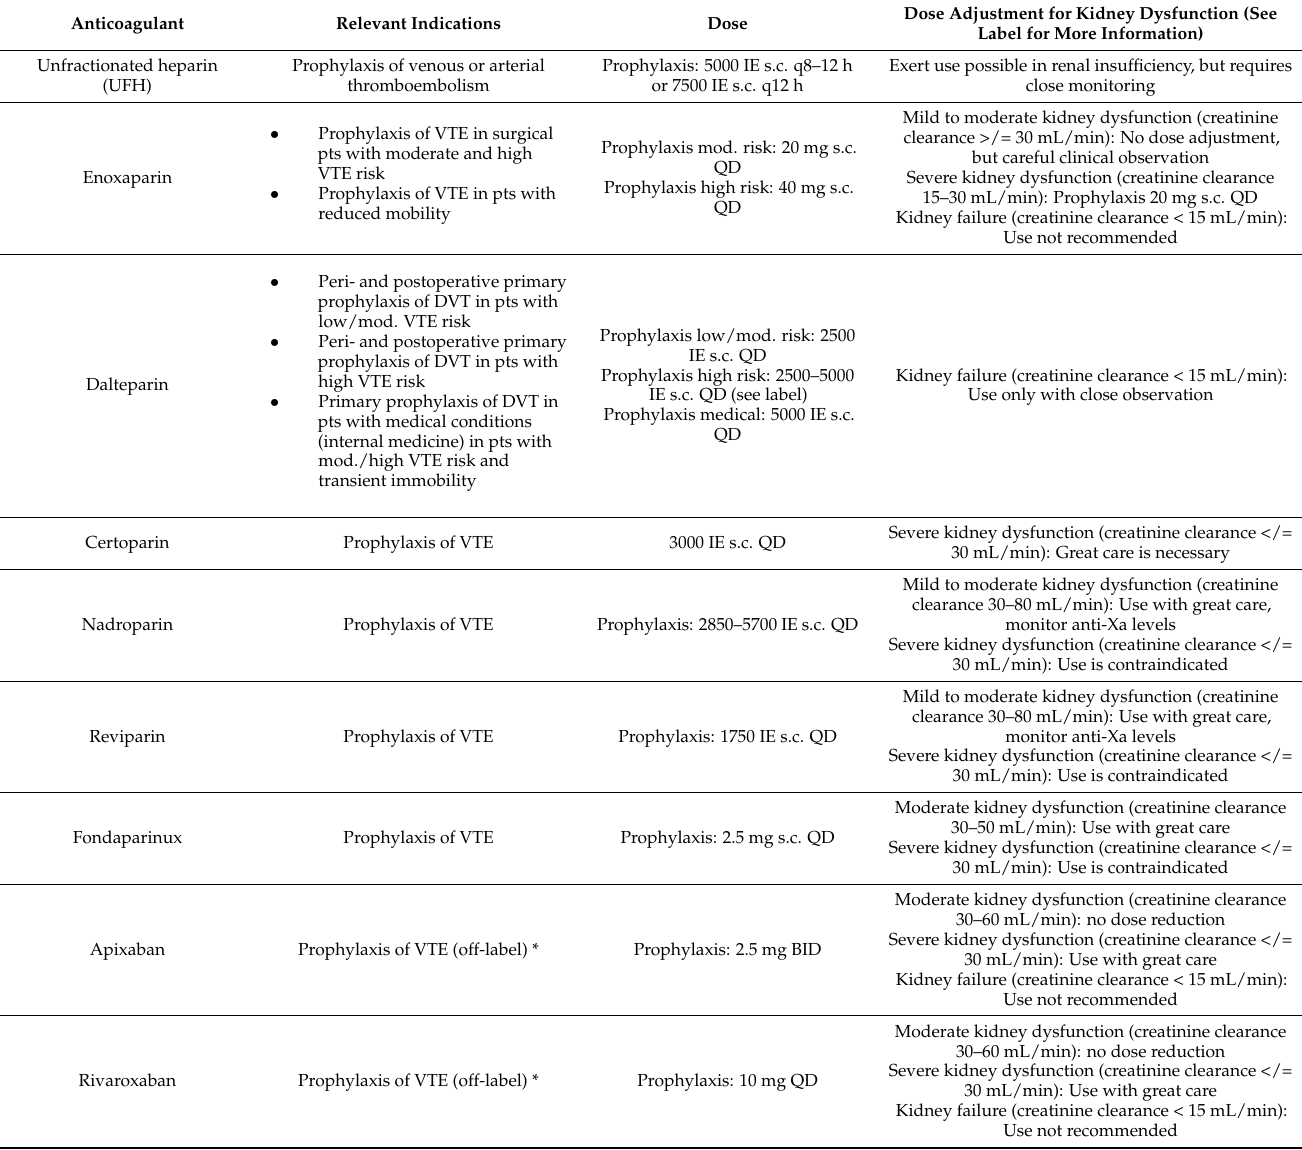
Table 3. Anticoagulant indications, doses, and dose adjustments for kidney dysfunction